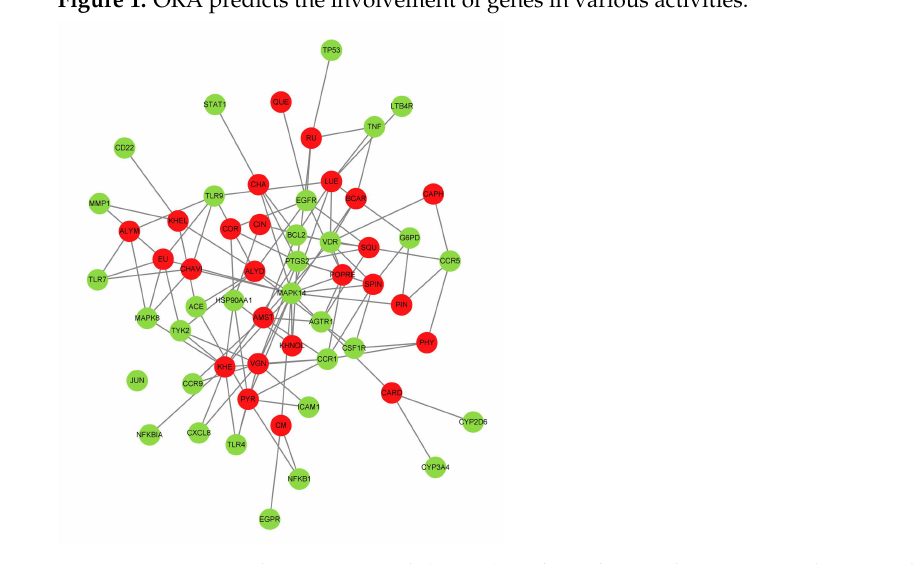
Figure 2. Compound-target-network (C-T-N) analysis depicts the interaction between the phytocom- pounds and human COVID-19 immune targets. Green color represents human COVID-19 immune targets and the red color indicates